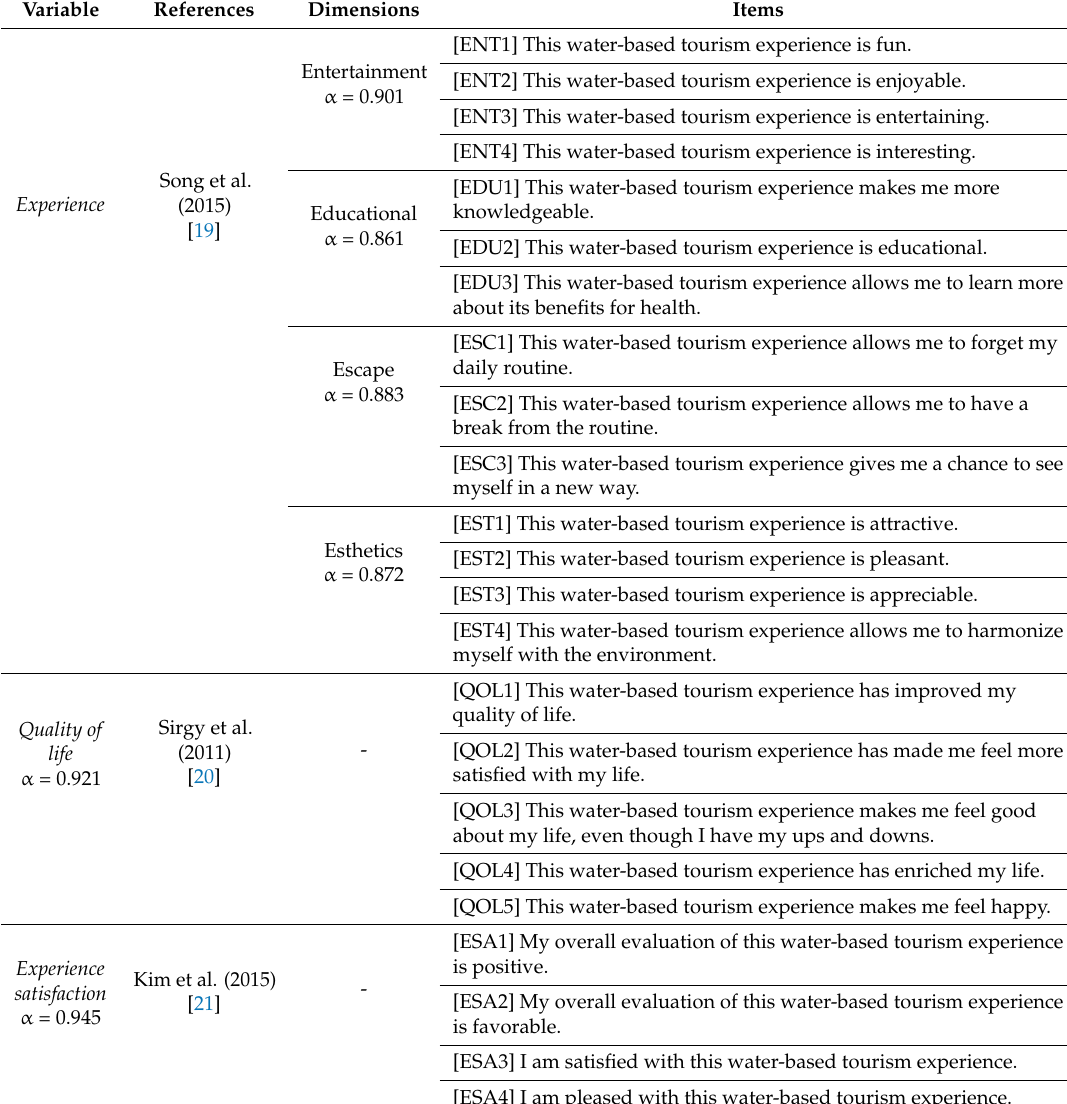
Table 1. Measures and reliability of the